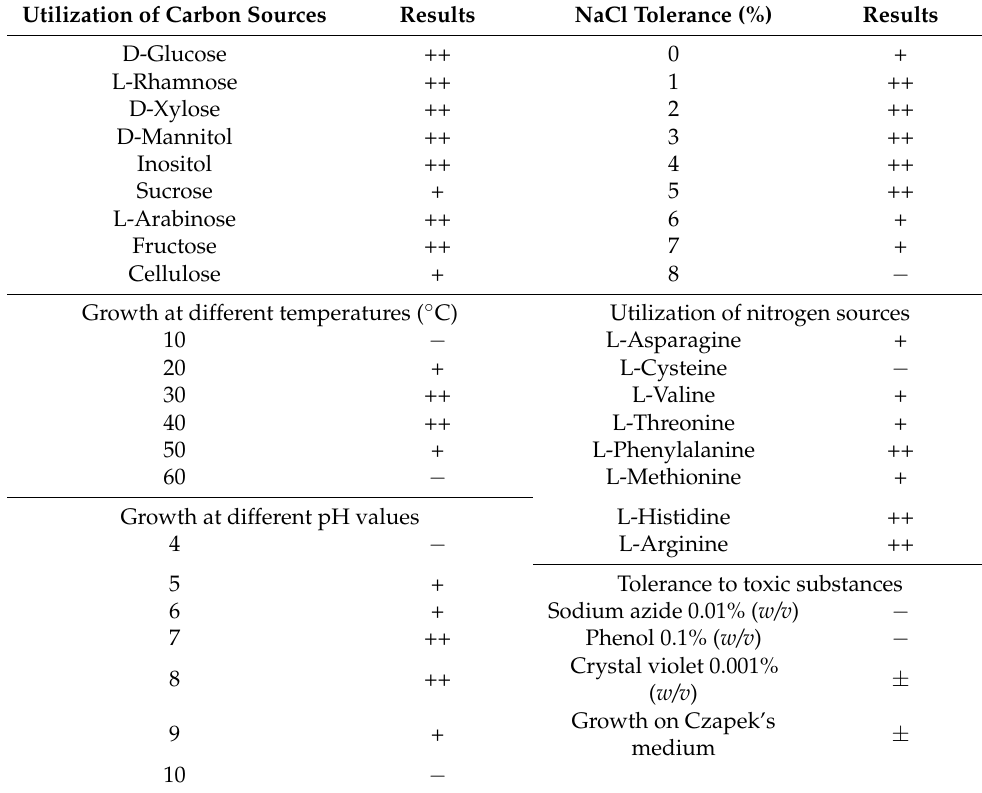
Table 2. Physiological characteristics of isolate